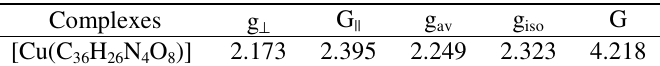
Table 4. ESR data of the Cu(II) complex of the ligand [HL]